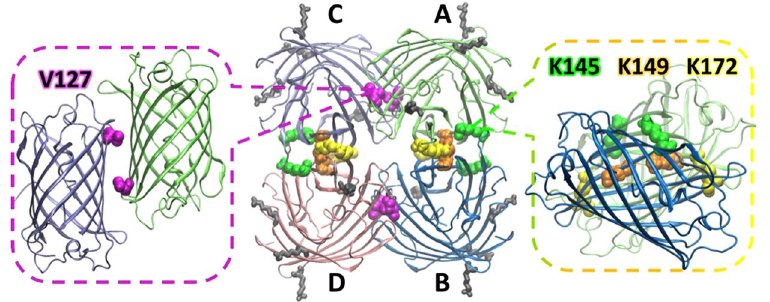
Figure 1. SAASoti tetrameric model structure (based on the Kaede structure PDB code: 2GW3). Right: rotated charged AB interface, K145, K149 and K172 are shown in green, orange and yellow, respectively; center: 3D model with two distinct interfaces – AB and AC; left: rotated hydrophobic AC interface, V127 is shown in magenta. Surface-facing lysines K39, K41, K112 and K139 are shown in